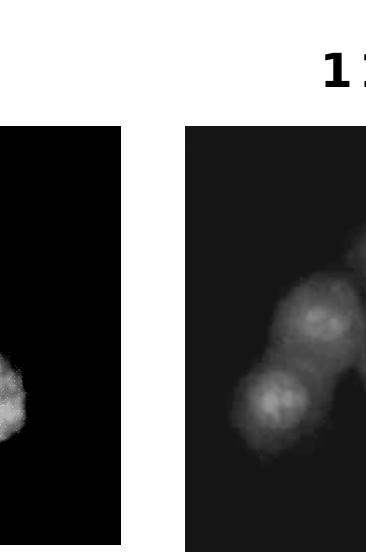
Figure 4. Nuclear morphology of HepG2 cells stained with ethidium bromide. The cells were incubated in the absence (control) or presence of 100 µM chalcone 1 after 24 h